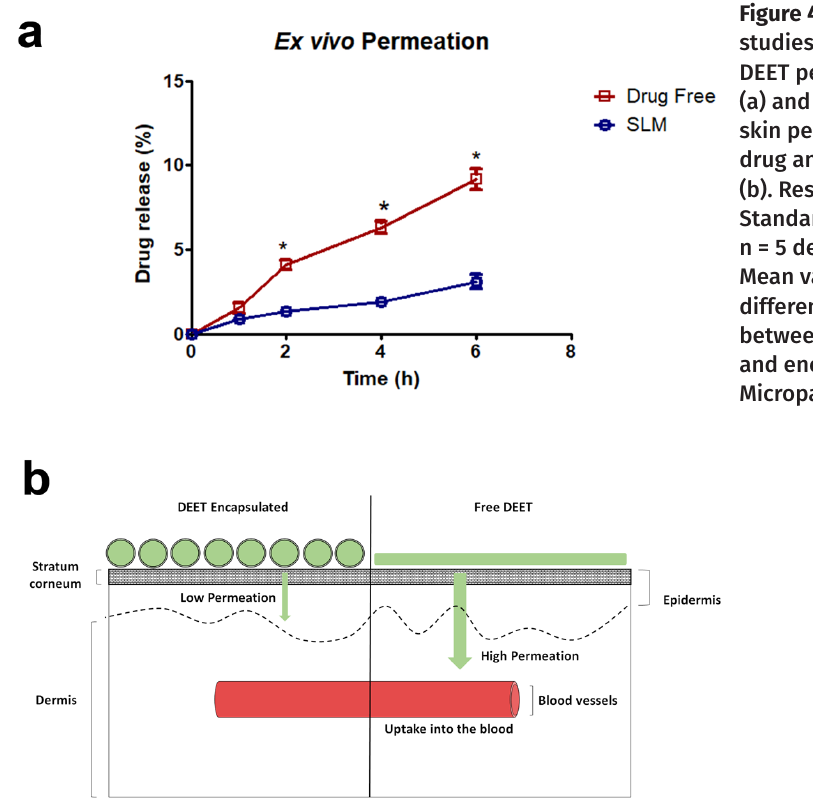
Figure 4. Ex vivo permeation studies: amount